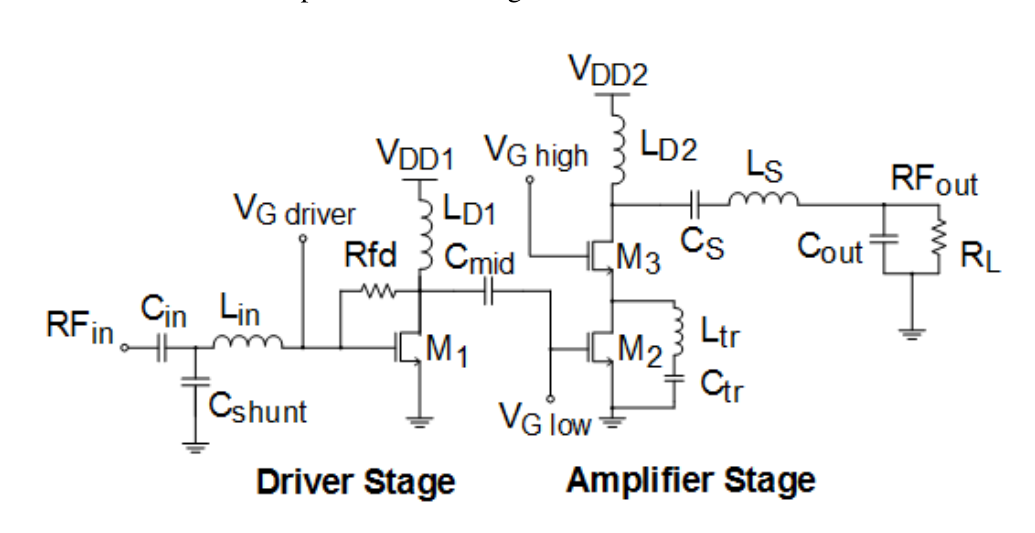
Figure 11. Schematic of a cascode Class E power amplifier.